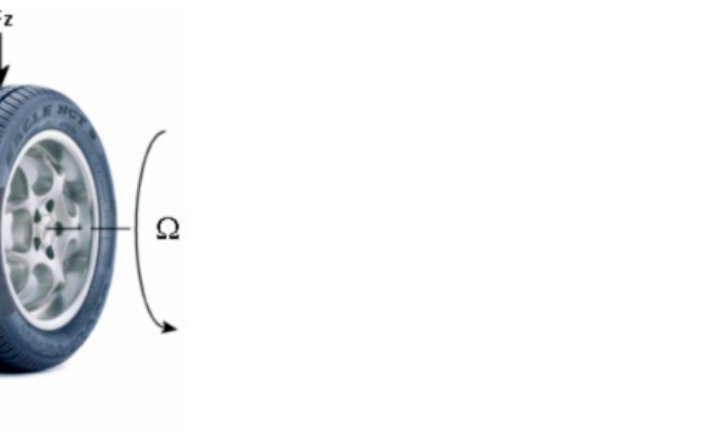
Figure 2. Speed and forces in the tire-road contact patch area. Adapted from [16], MathWorks: 2020.